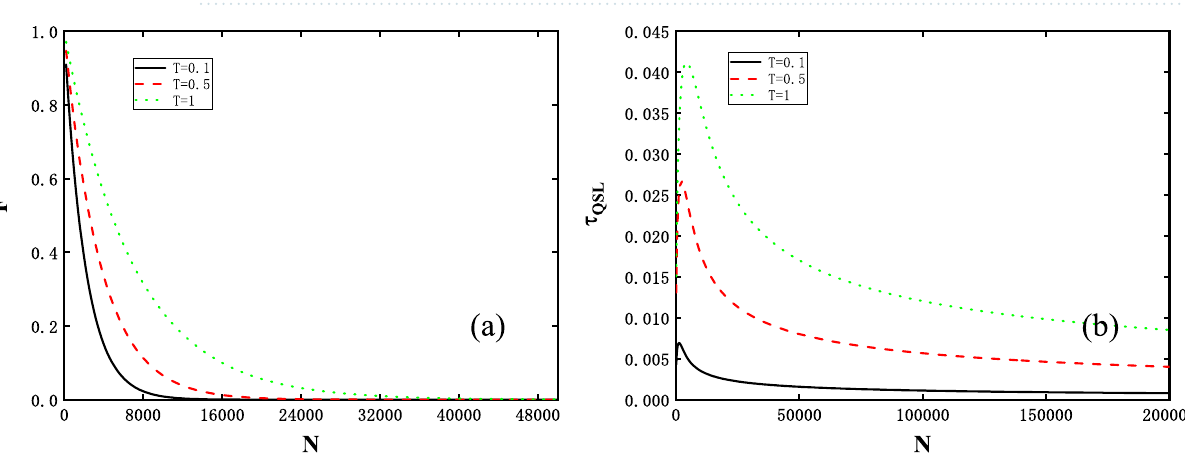
QSL shows a cusp-like shape.